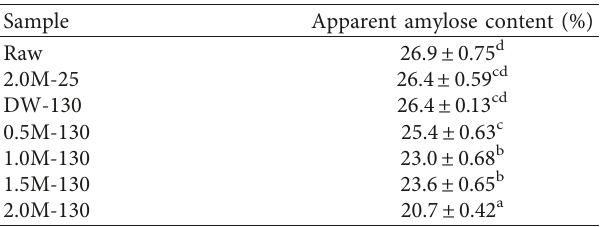
Table 3: Apparent amylose content of raw and malic acid-treated sweet potato starches.